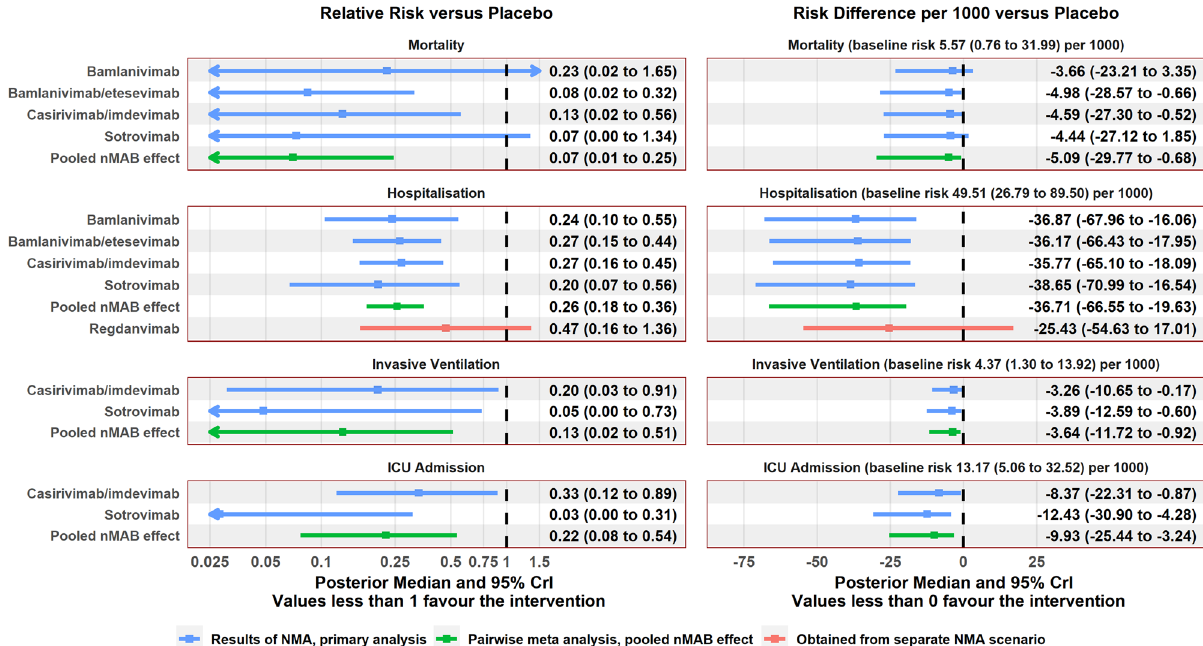
Figure 3. Summary of relative and absolute treatment effects for each treatment compared with SoC from the NMA, efficacy outcomes. Results obtained from Bayesian random-effects network meta-analysis model. Risk difference per 1000 patients represents the difference in number of events that would be expected to if 1000 patients with nMABs rather than SoC. Baseline risks for each event type were obtained by pooling event rates from the placebo arms across all included studies using a random-effects model. Treatment effects for regdanvimab were obtained from a separate scenario analysis. Regdanvimab is not included in the ‘pooled nMAB effect’ as no studies of regdanvimab meeting the inclusion criteria of the review were identified.